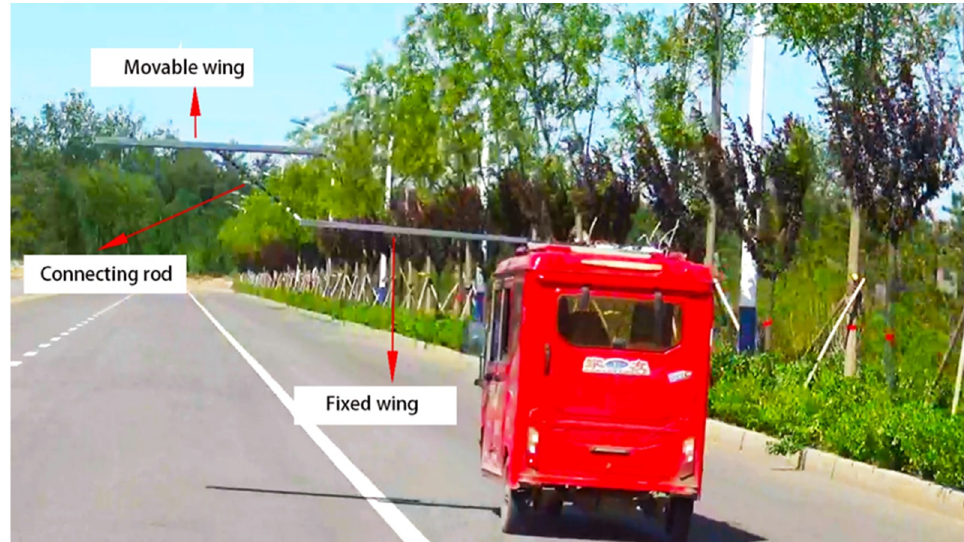
Figure 5. Ground vehicle test platform.